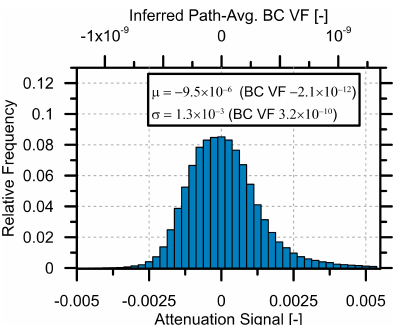
Figure A3. Light attenuation due to beam steering and inferred black carbon (BC) volume fraction (VF) presence due to the atten-